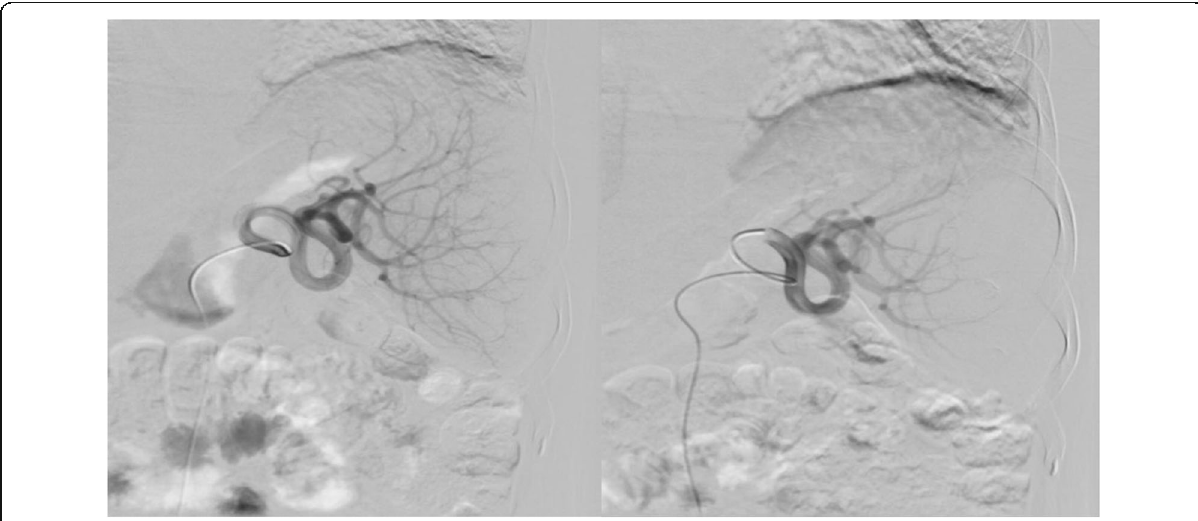
Fig. 1 Digital subtraction angiography of the splenic artery before ( left panel ) and after ( right panel ) embolisation, showing 60 – 70% occlusion of the parenchymal vascularity of the